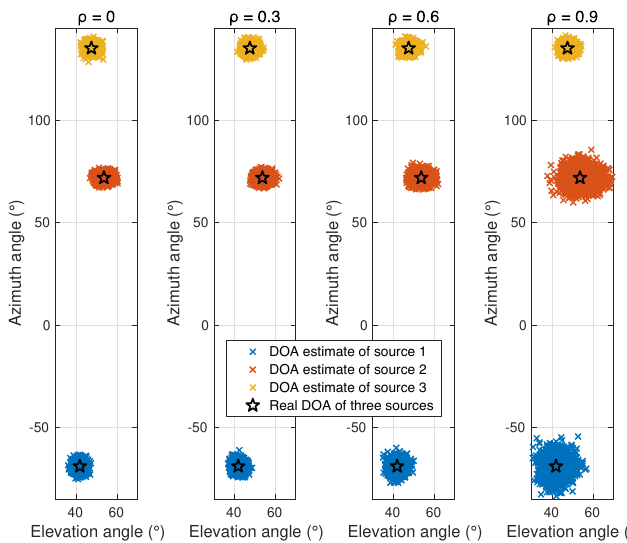
Figure 9. RMSE of DOA estimation versus correlation coefficient from 0 to 0.9. ( a ) RMSE of the elevation angle, ( b ) RMSE of the azimuth angle.